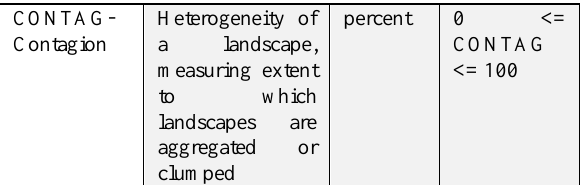
Table 1. Spatial metrics used in the